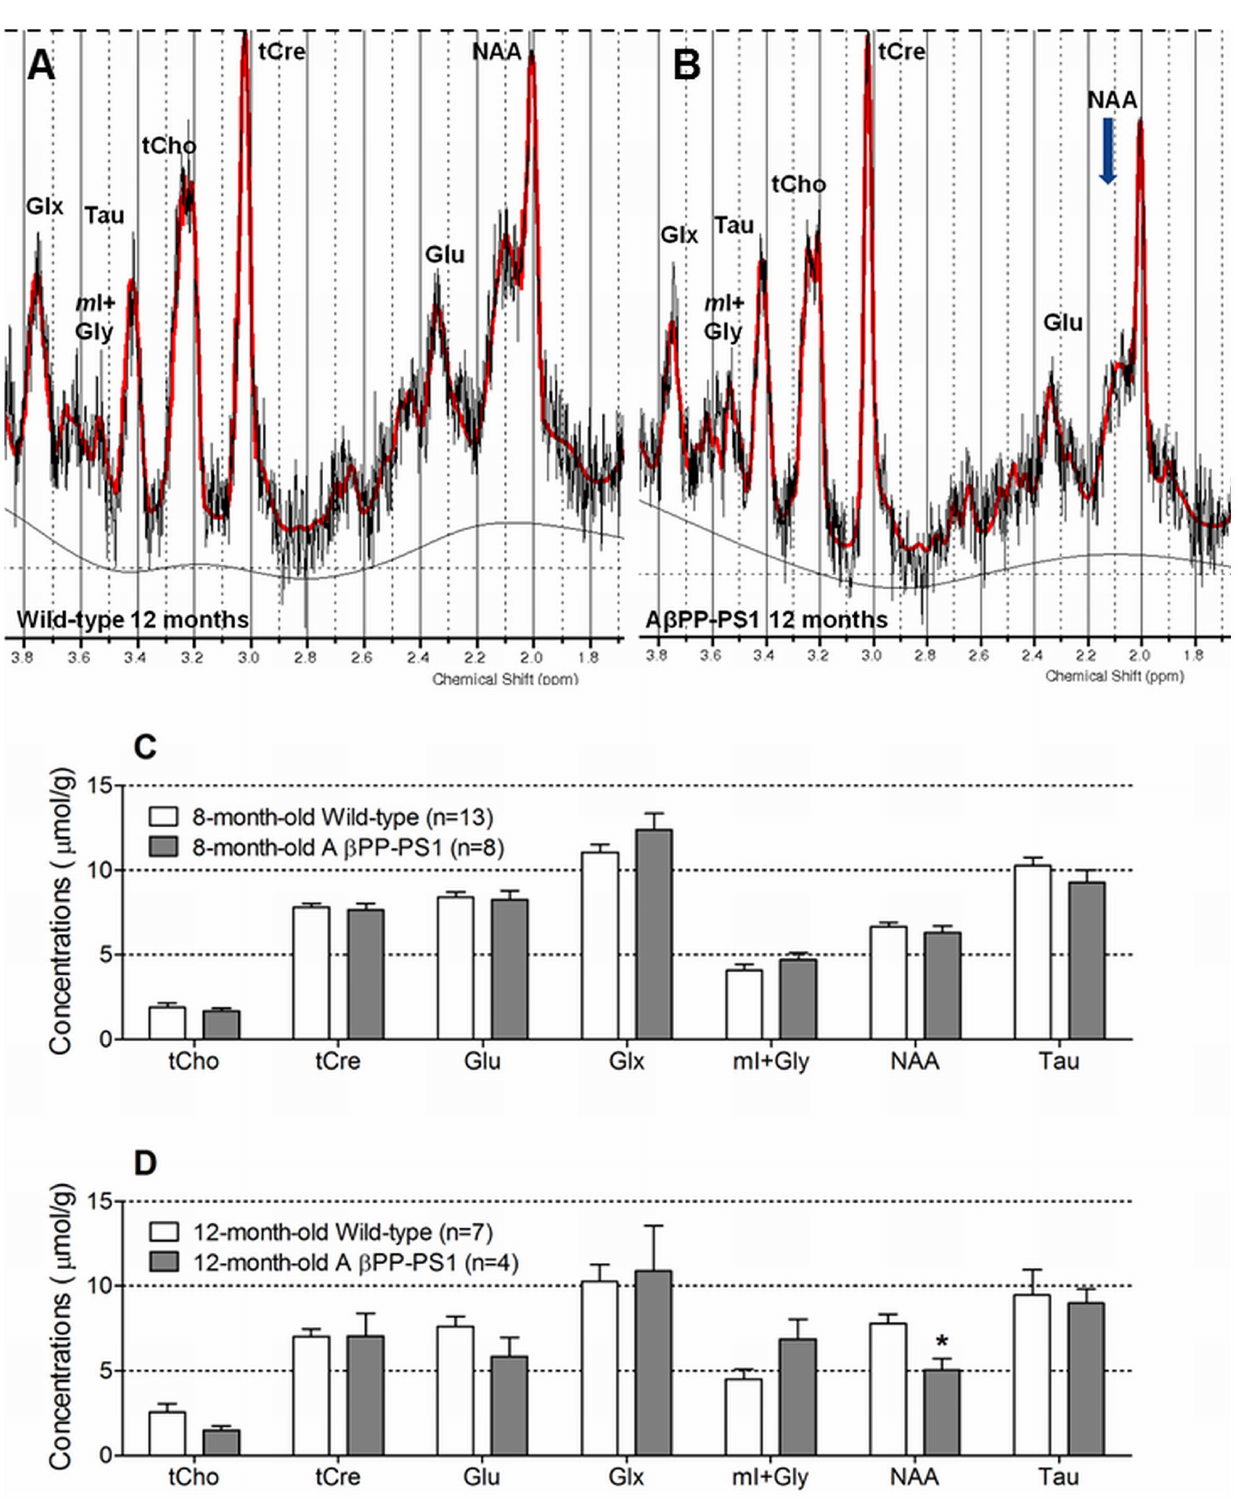
Figure 8. Neurochemical profile of the hippocampus measured by single voxel 1 H MRS at 7 Tesla. A: Representative 1 H MR spectra acquired from the hippocampus of a 12-month-old wild-type mouse. B: Representative 1 H MR spectra acquired from the hippocampus of a 12- month-old A b PPswe-PS1dE9 transgenic mouse. Notice the decreased NAA peak in A b PP-PS1compared to wild-type. C: At 8 months of age, no differences between wild-type (n=13) and A b PP-PS1 mice (n=8) were observed in the hippocampal neurochemical profile. D: At 12 months of age, A b PP-PS1 mice (n=4) had significantly lower concentrations of NAA than wild-type mice (n=7), * p , 0.05. tCho=choline-containing compounds; tCre=creatine and phosphocreatine; Glu=glutamate; Glx=glutamine and glutamate; m I + Gly= myo -Inositol and glycine; NAA= N -acetylaspartate; Tau=taurine.